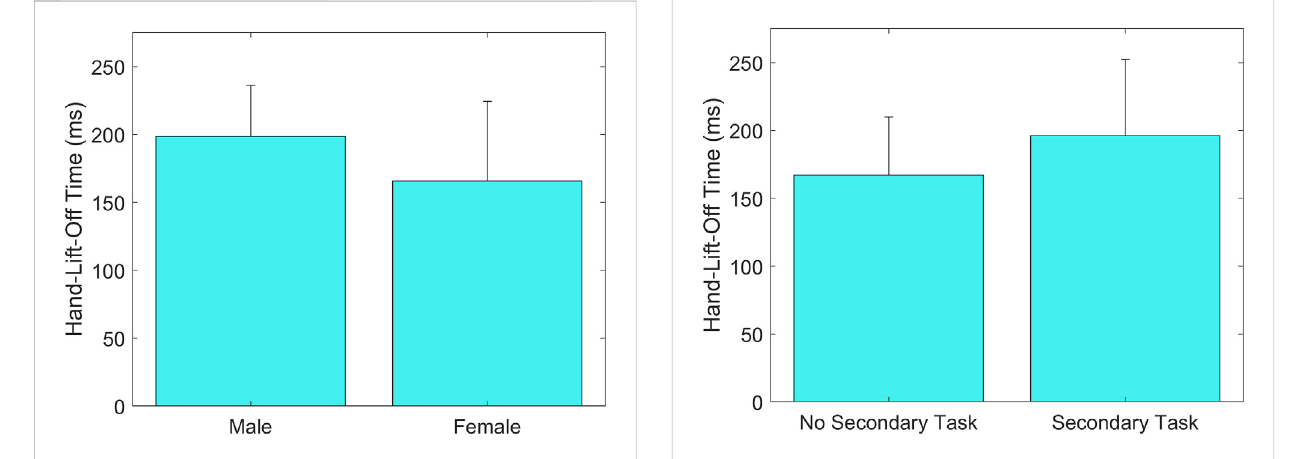
FIGURE 8 Group means ± SD for Hand-Lift-Off Time for male and female drivers.